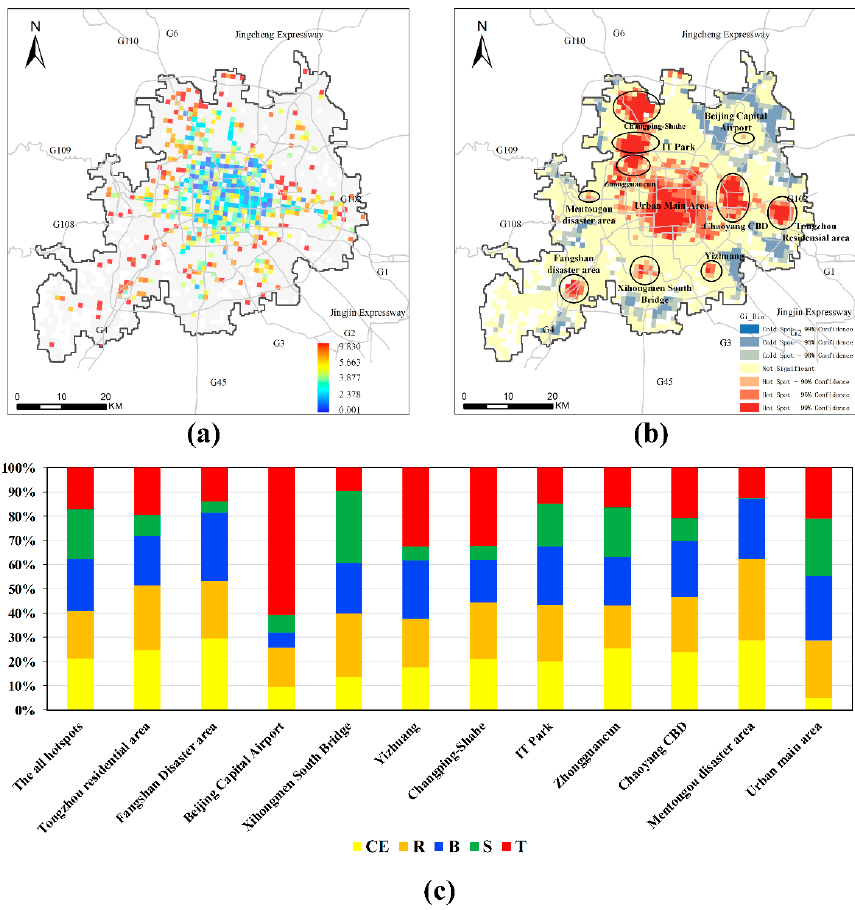
Figure 12. Spatial distribution of the HERI values ( a ); HERI hotspot analysis results ( b ); Percentage of POI types in each HERI hotspot area ( c ). POI types in each HERI hotspot area ( c